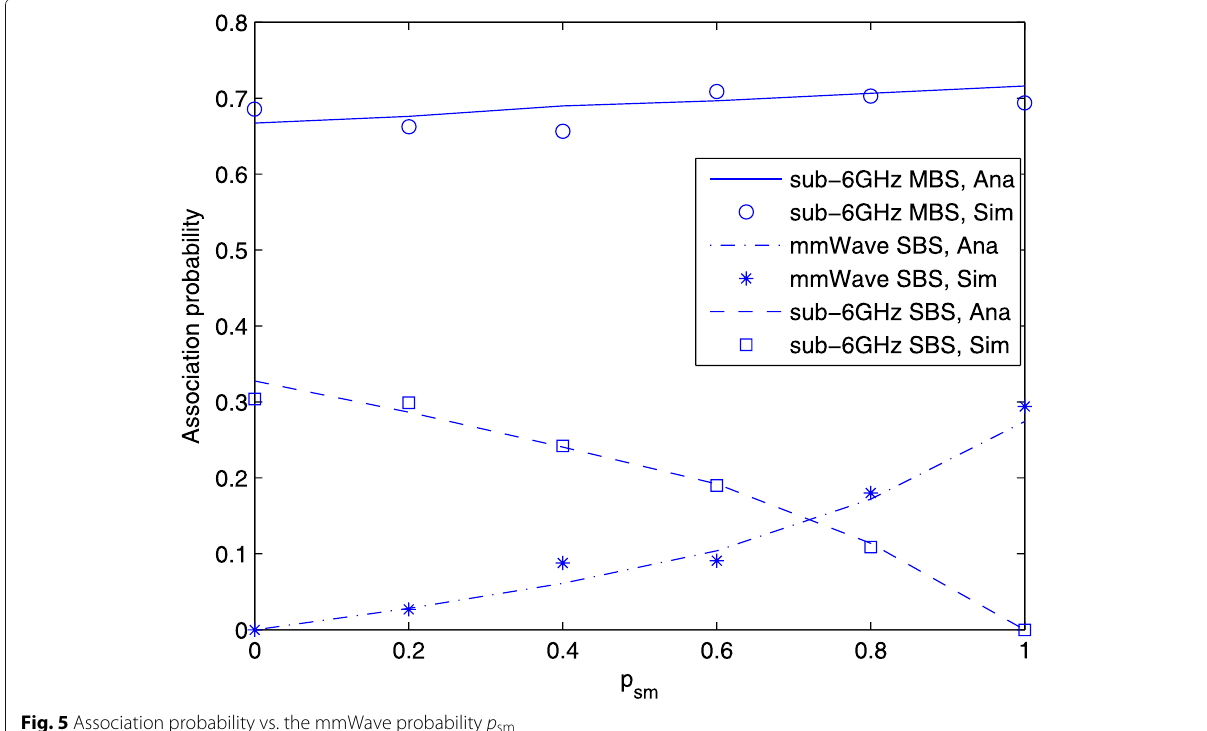
Fig. 5 Association probability vs. the mmWave probability p sm